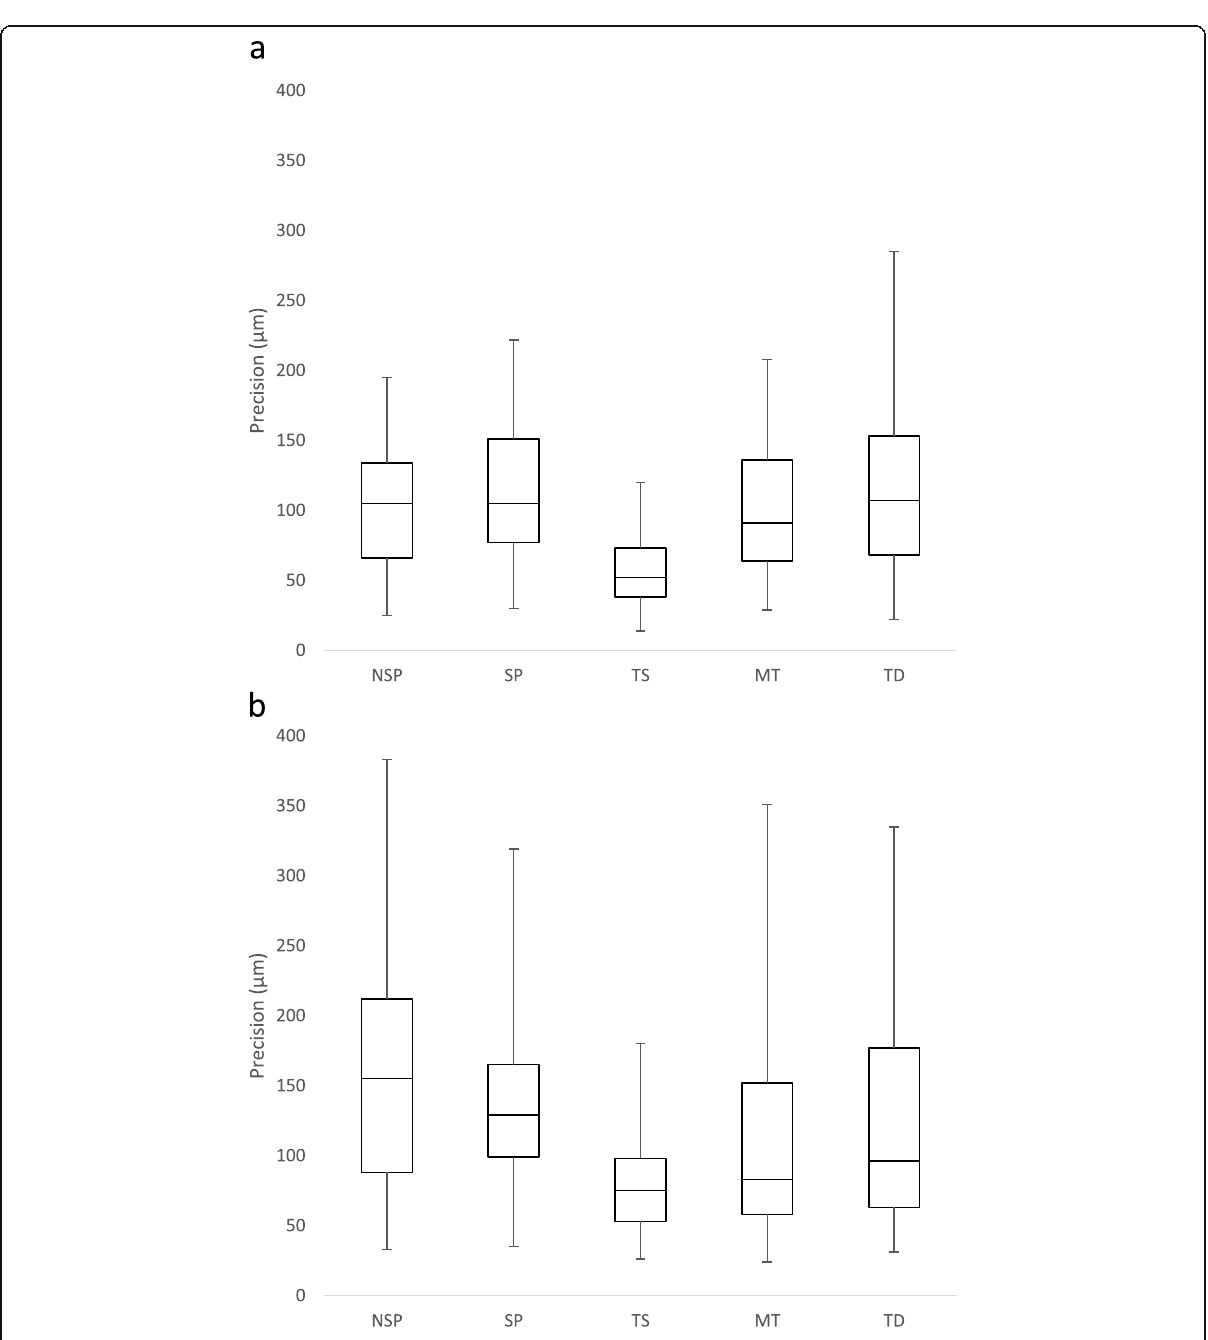
Fig. 4 Box plot diagrams of the precision of every impression technique. a Parallel implants model. b Divergent implants